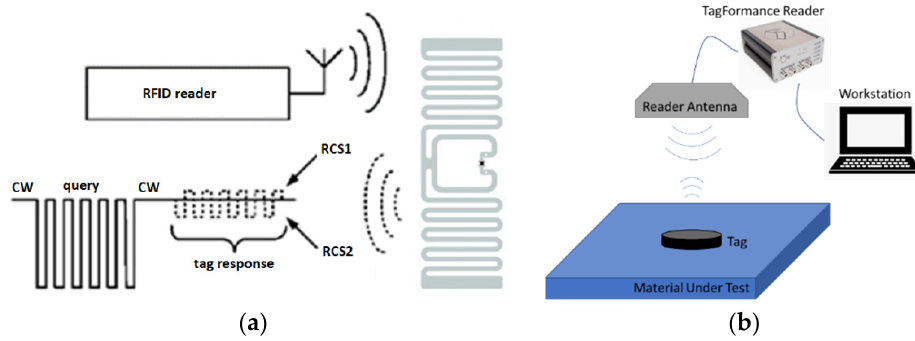
Figure 1. (a) RFID principle, (b) RFID-based material identification and crack sensing system. Figure 1. ( a ) RFID principle, ( b ) RFID-based material identification and crack sensing